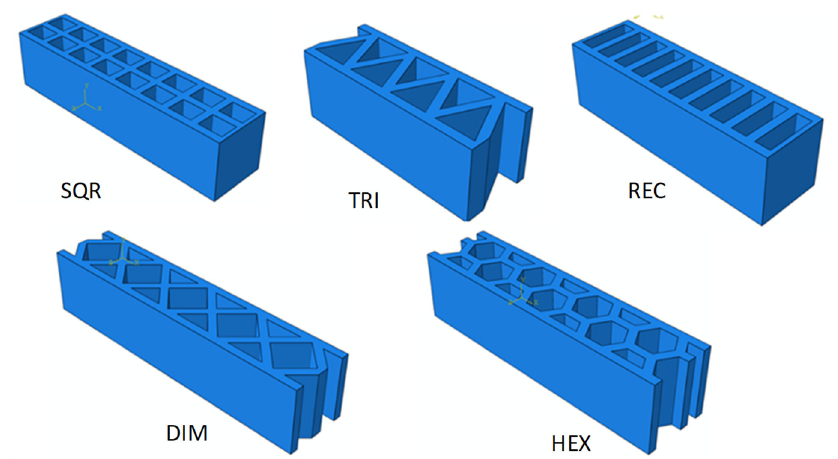
Figure 1. Isometric view of selected sections of 3DPC walls with different infill structures.